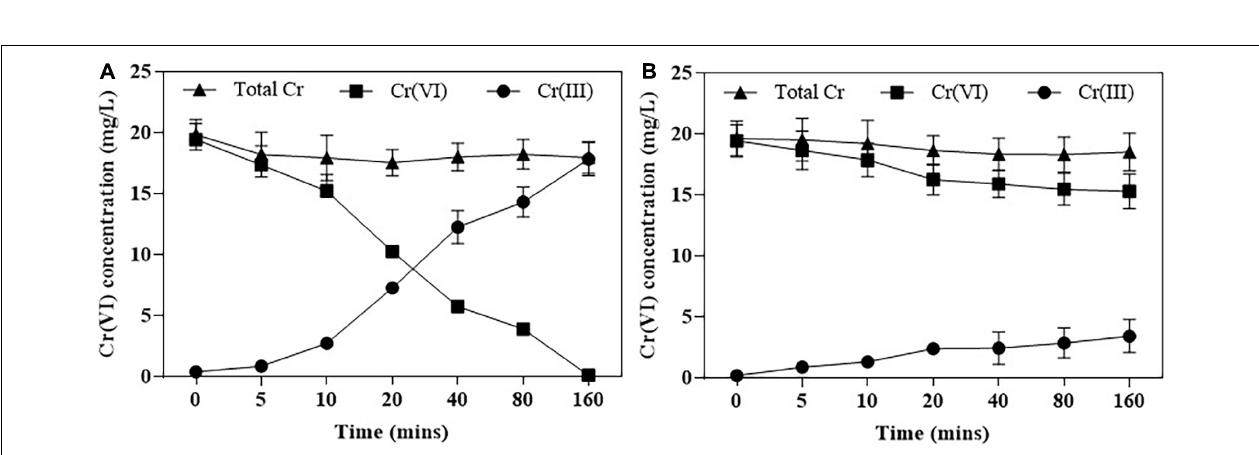
FIGURE 4 | The inhibition rate of Cr(VI) on yeast growth (A) and Cr(VI) reduction rates of yeasts (B) . Mutant strains ( (cid:49) ycf1 ) were transformed with empty vector pYES2, pYES2- niiA or pYES2- niaD in SD-Ura liquid medium with or without metal supplementation.